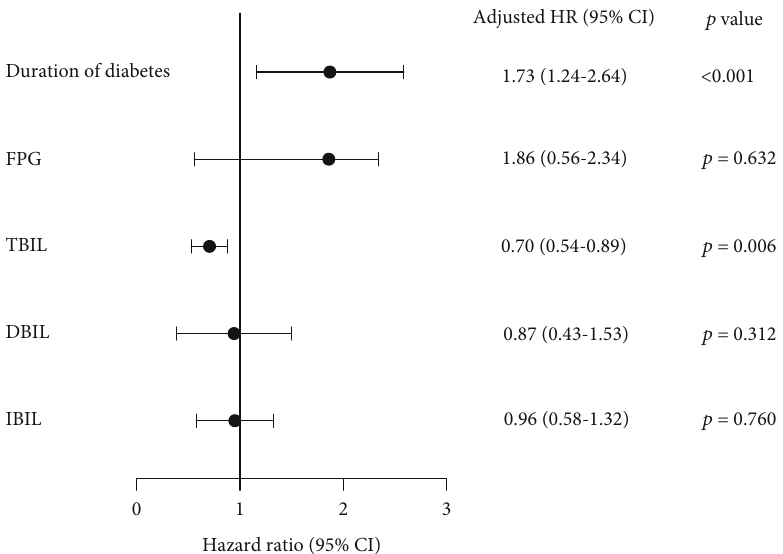
Figure 2: Cox proportional hazards regression model: the risk factors for DR progression.